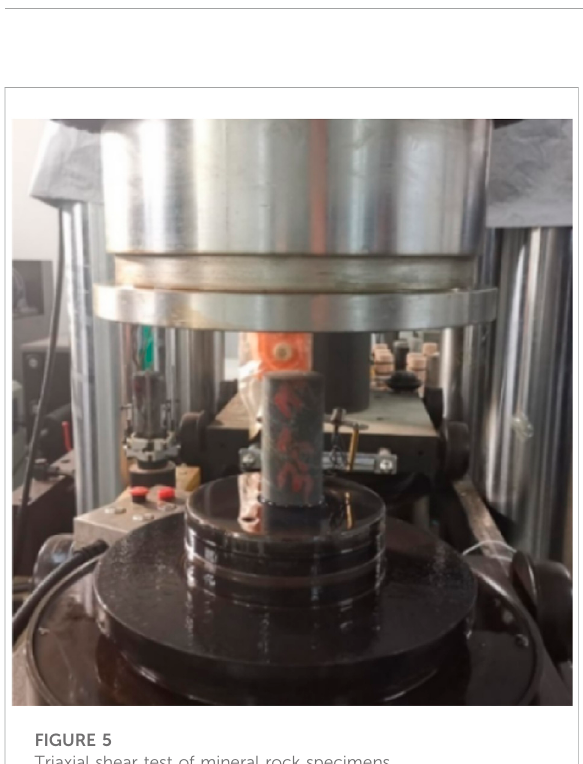
FIGURE 5 Triaxial shear test of mineral rock